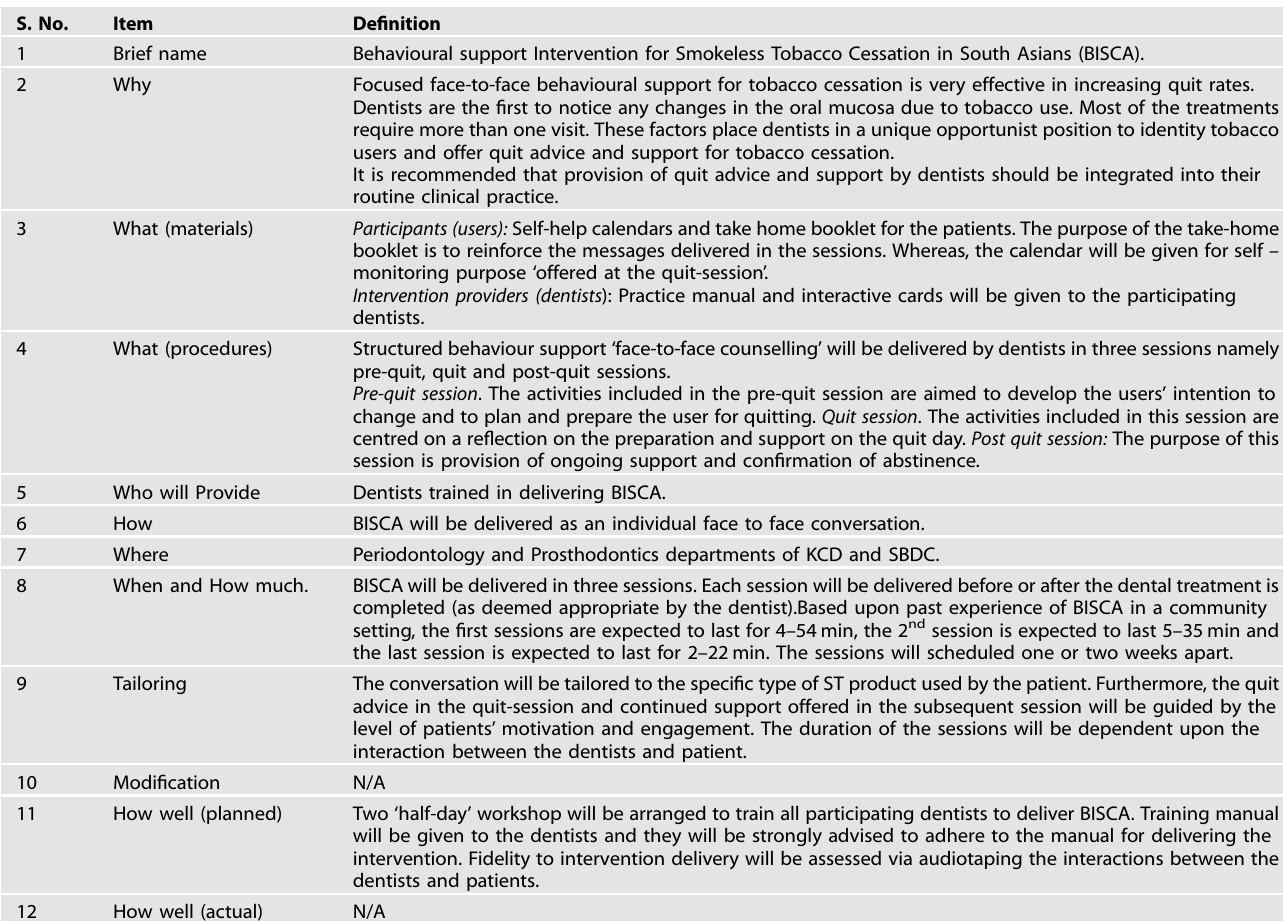
Table 1. TIDieR Checklist for the